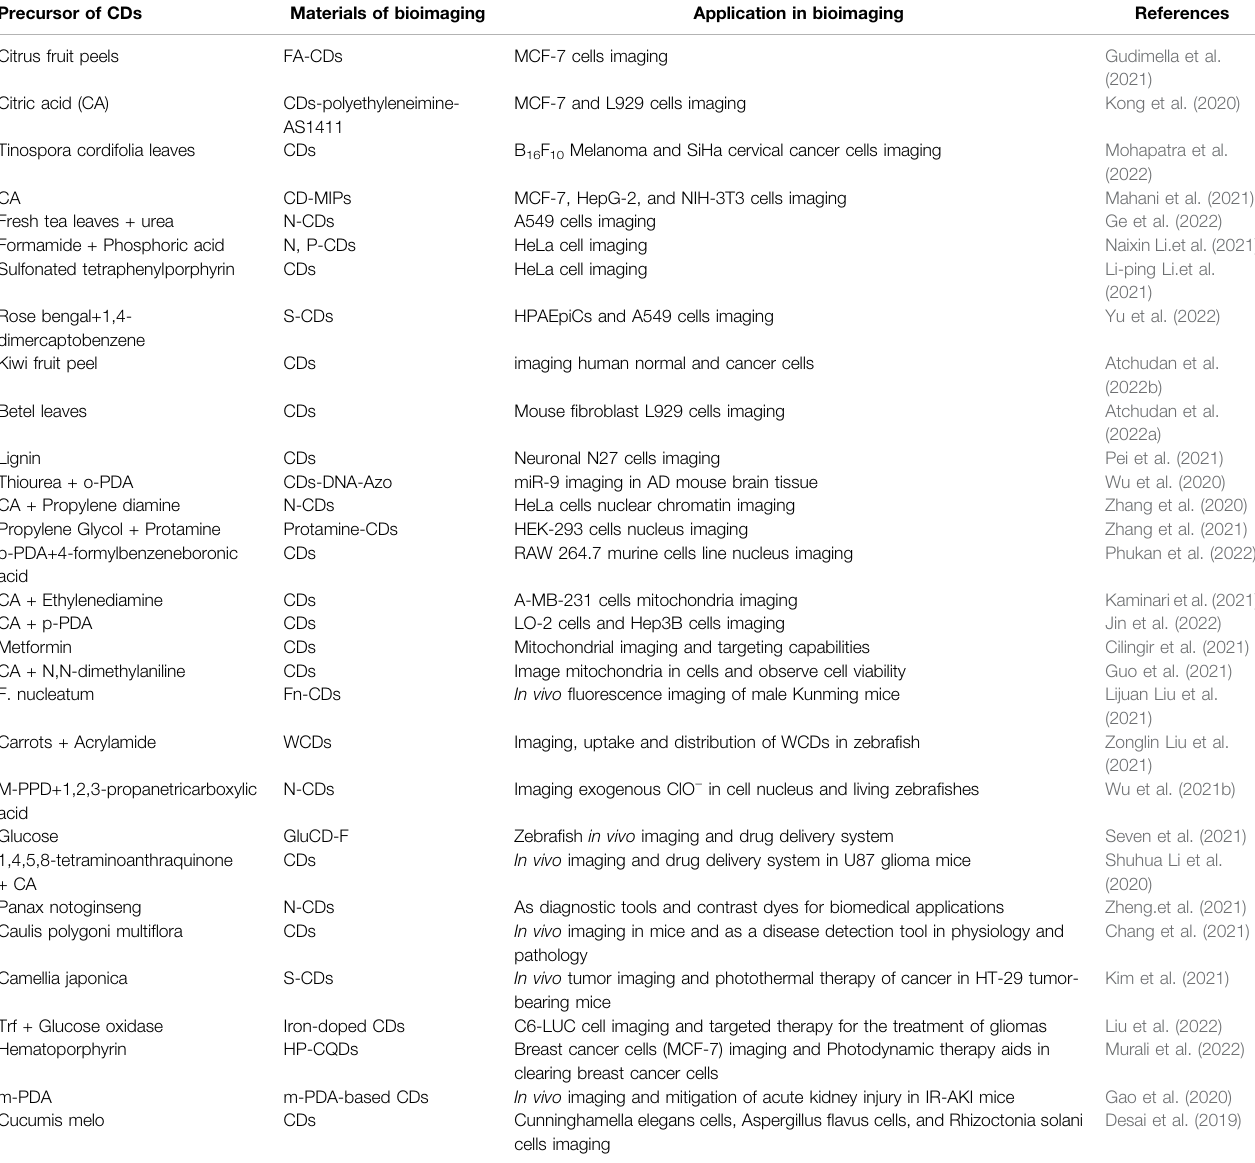
TABLE 1 | Application of different types of carbon dots in bioimaging. Precursor of